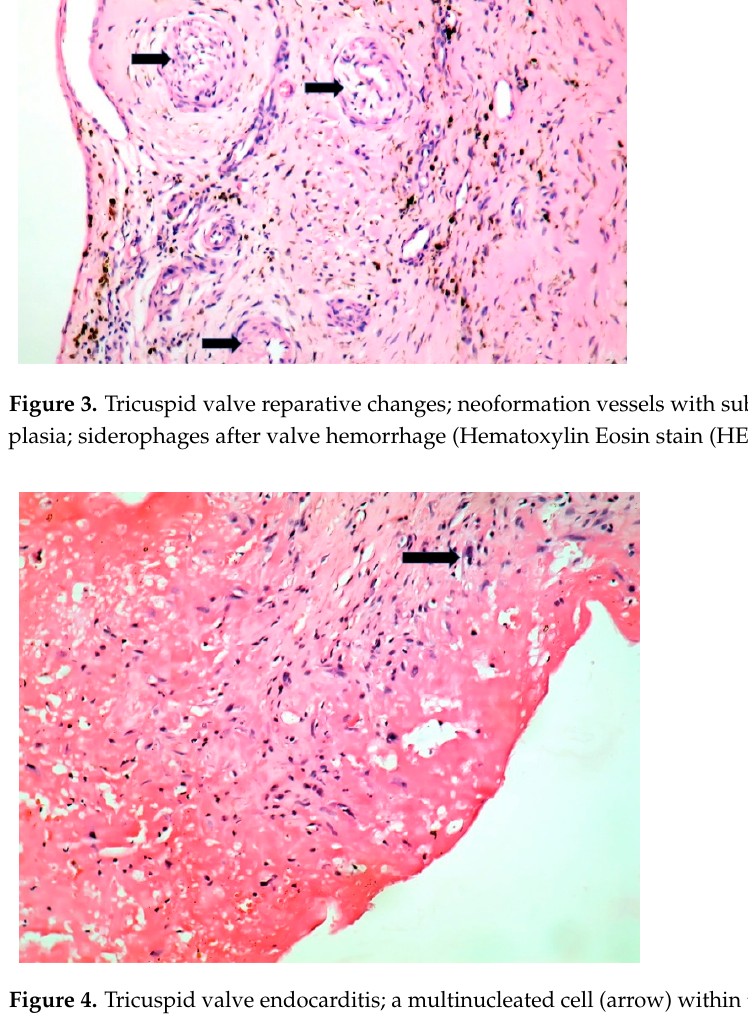
Figure 5. Endomyocardial fragment with mural endocarditis (the asterisk marks the myocardium), giant and foamy cells (arrows). * Special stains did not identify microorganisms (HE stain × 10). Figure 6. Foamy cells (arrows) (HE stain × 40).